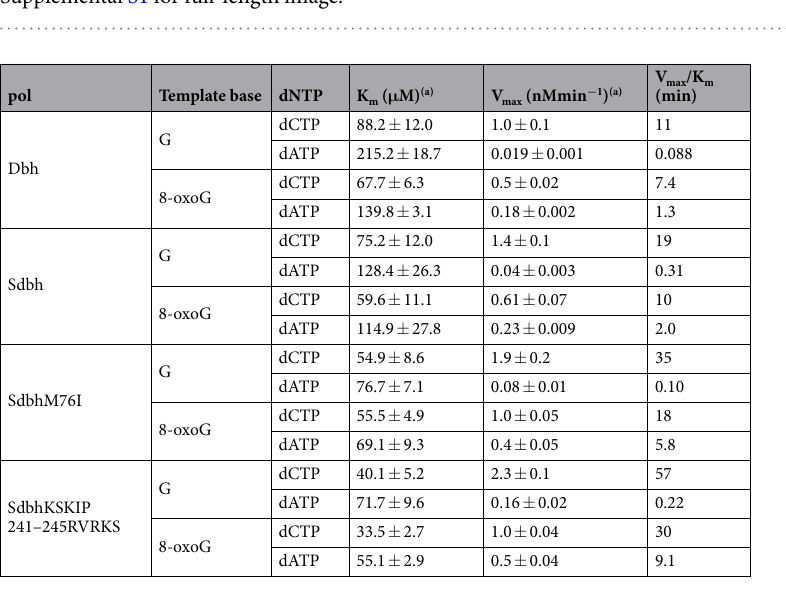
Figure 5. Processivity of Sdbh variants. The ability of the variants SdbhKSKIP241–245RVRKS and SdbhM76I to extend a FAM-labeled primer annealed to single-stranded M13mp18 DNA from a single DNA binding event in the presence of a DNA trap. The analysis method employed was the same as that used in Fig. 2. See Supplemental S1 for full-length image.